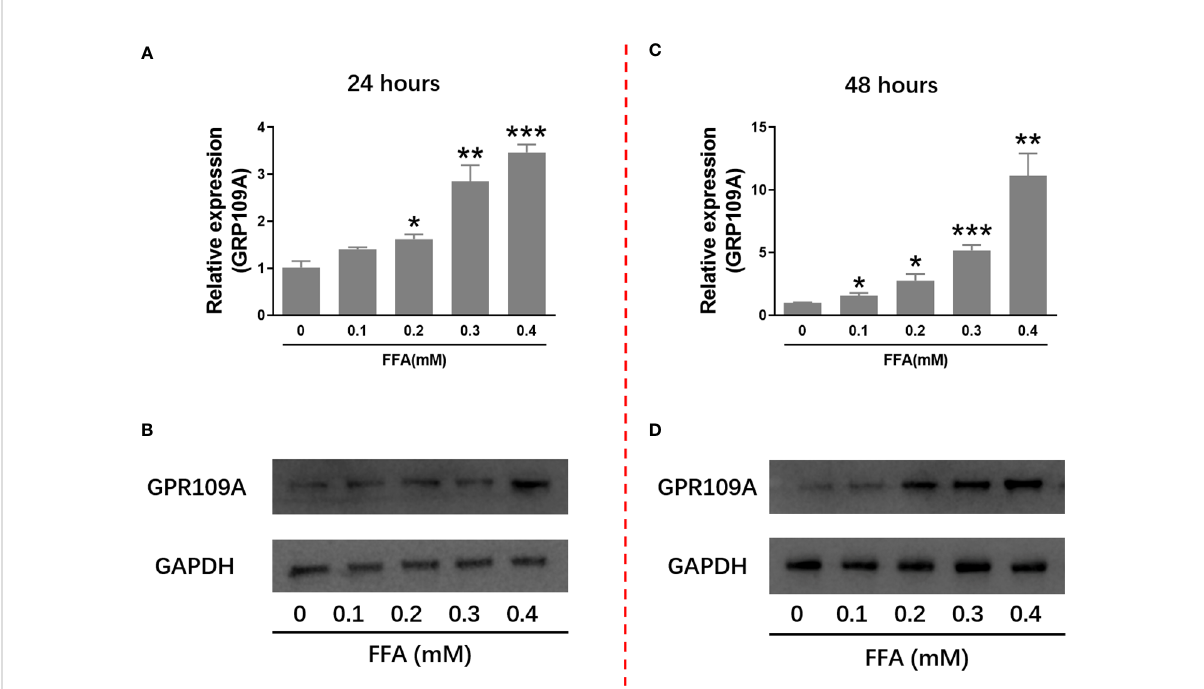
FIGURE 1 FFA increased GPR109A mRNA expression and protein level in INS-1 cells. INS-1 cells were treated with different concentrations of FFA for 24 or 48 hours. (A, C) Total RNA was extracted for quantitative PCR. (B, D) Total protein was extracted for western blot analyse. Data were from three independent experiments and represent mean ± SD. n=3, *P < 0.05, **P < 0.01 and ***P < 0.001 compared to the control group (0 mM